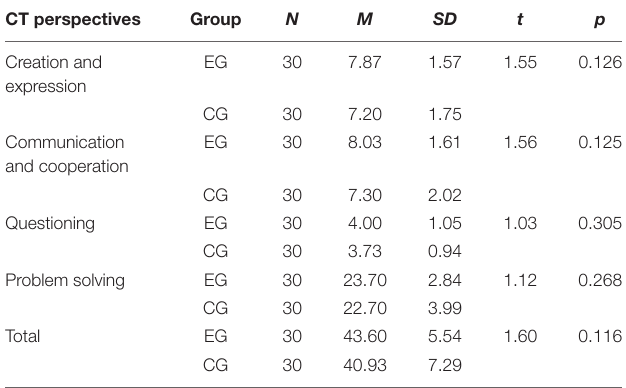
TABLE 11 | The independent sample t -test of the two groups’ CT perspectives pre-test. CT perspectives